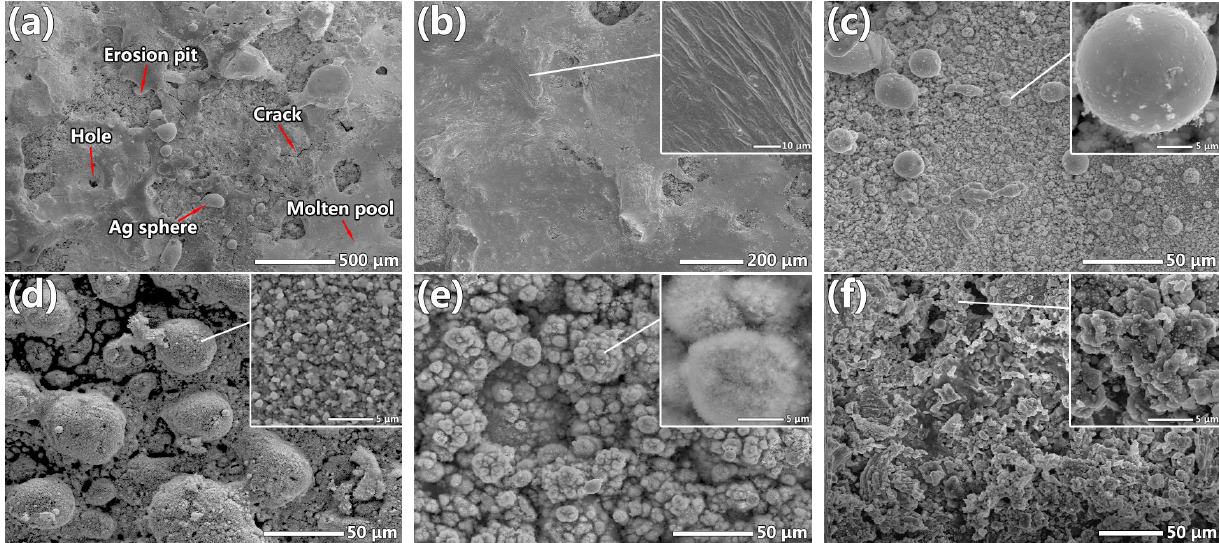
Fig. 7 (a) Typical micro-morphologies on the contact surface of Ag/20TSC. (b) Amplified image of the molten pool, and the inset shows its inner. (c–f) exhibit the different erosion morphologies of the Ag after electric arc discharging, specifically the spherical, the hillock-like, the coralloid, and the irregular. And the insets show their enlarged images. The representative micro-morphologies on the surface observed in the Ag/20TSC contact, including holes, of the eroded Ag/CdO contact after electric arc discharging erosion pits, cracks, molten pools, and Ag spheres, test are displayed in Fig. 8. The surface morphologies were also found on the surface of the Ag/CdO contact.